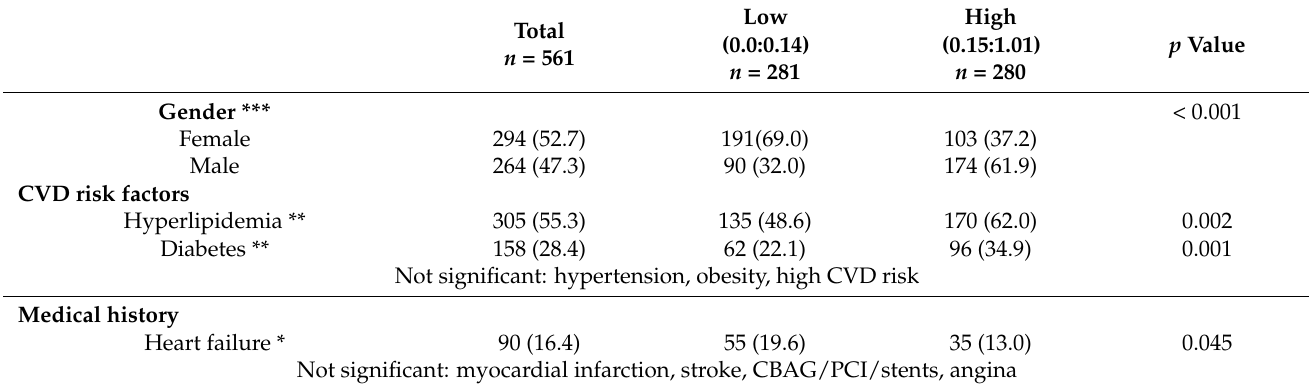
Table 2. Characteristics of Study Participants Stratified by Urinary Levels of